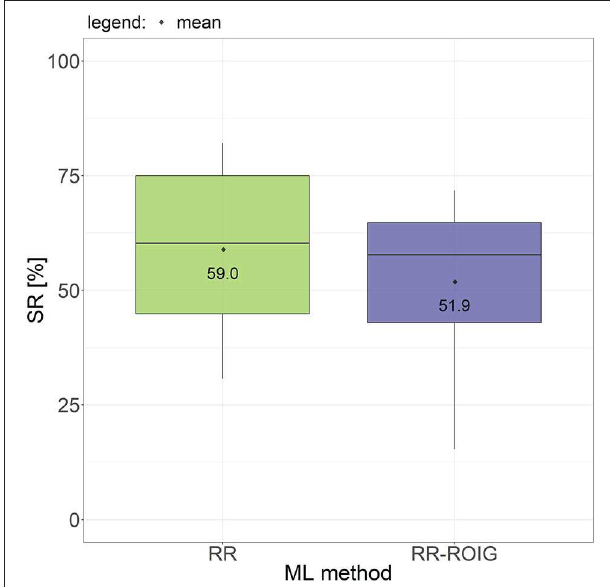
FIGURE 8 | Boxplots and means of the success rates for all tasks across all participants grouped according to the machine learning method used.